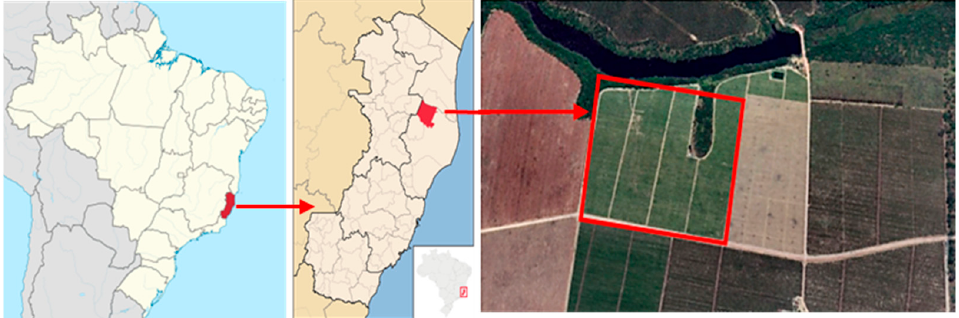
Figure 1. Location of the experimental area. The red frame indicates the location of the experimental treatments